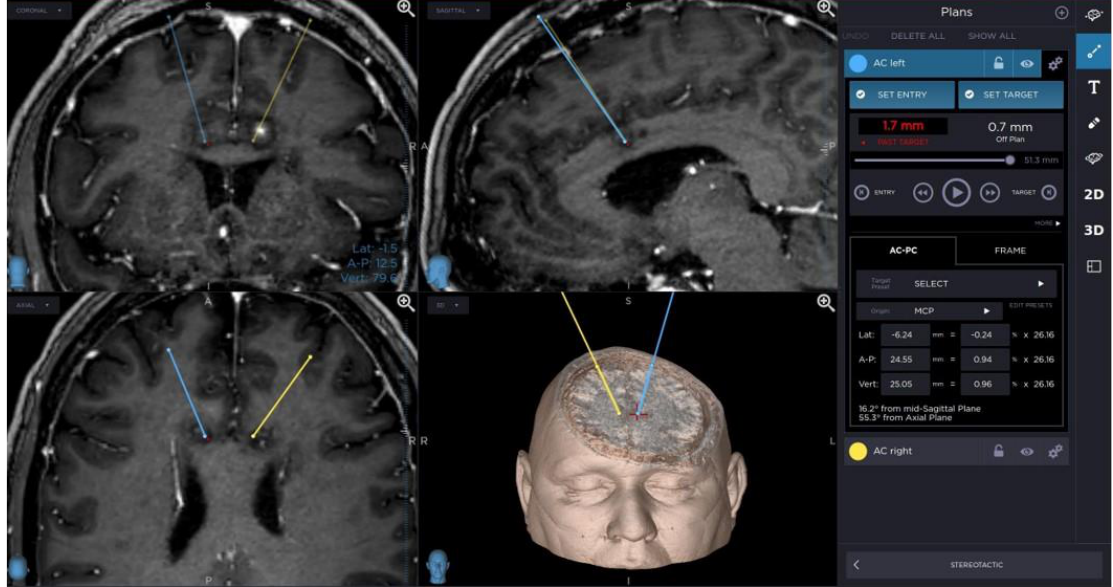
Figure 1. Planning of cingulotomy